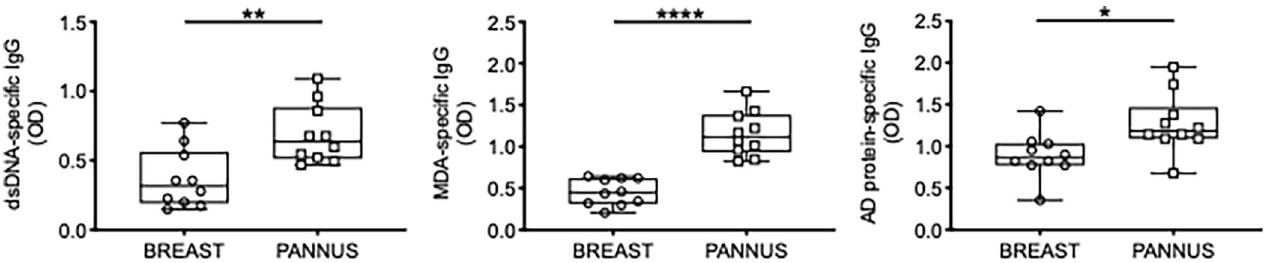
Fig 4. Higher secretion of IgG antibodies with autoimmune specificities in culture supernatants of pannus versus breast SVFs. Supernatants from unstimulated breast and pannus SVFs were collected after 10 days and analyzed by ELISA for the presence of autoimmune IgG. Mean comparisons between groups were performed by Student’s t test (two-tailed). * p < 0.05, ** p < 0.01, **** p < 0.0001. Each symbol represents an individual, n = 10 breast donors and n = 10 pannus